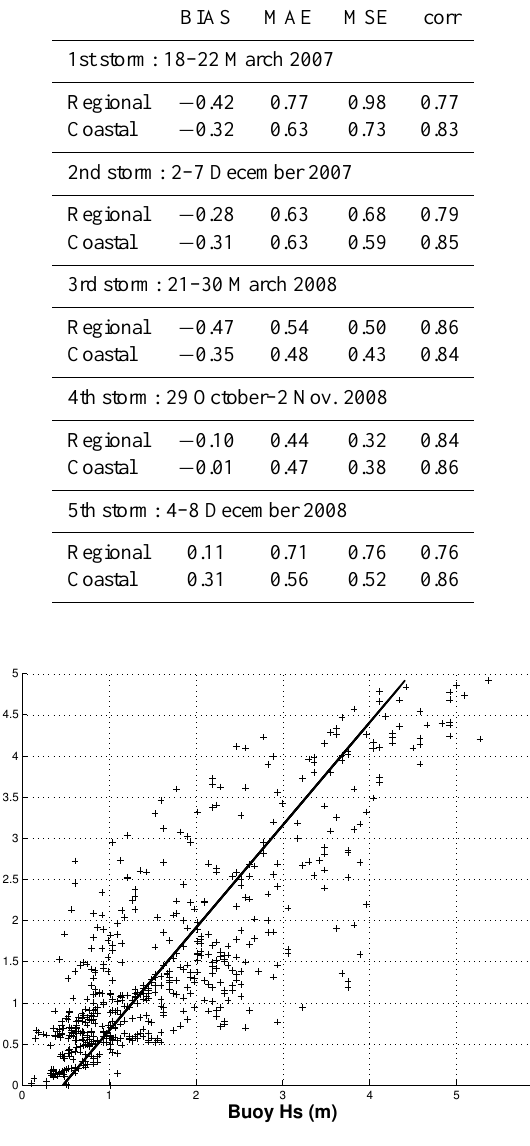
Fig. 4. Scatter diagram of buoy recorded vs. SWAN H s at Carrara. The storm events considered in the analysis are listed in Table 1.